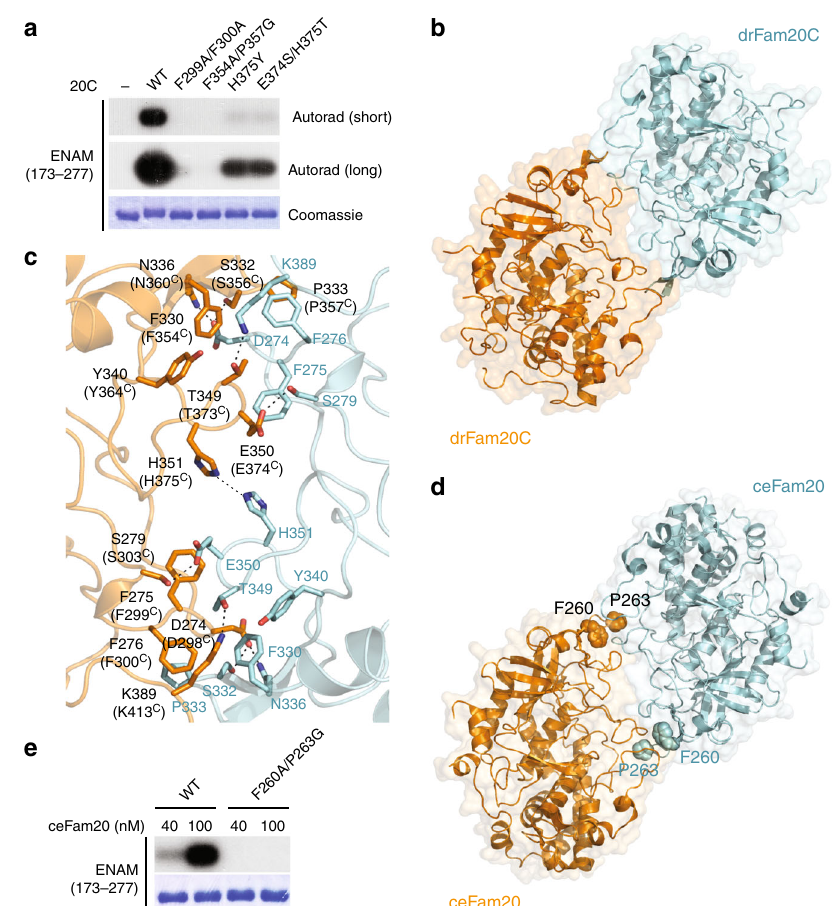
Fig. 3 Evolutionarily conserved dimer formation is required for Fam20C activity. a Fam20C mutants display reduced kinase activity. b The crystal structure of drFam20C reveals a homodimer structure resembling the human Fam20A − Fam20C heterodimer. c Detailed view of the drFam20C homodimer interface. All the residues involved in drFam20C homodimer formation are conserved in human Fam20C (the corresponding residues in human Fam20C are indicated in brackets). d Reexamination of the crystal structures of ceFam20 reveals a homodimer structure present in the crystal lattices of two different crystal forms (PDB entries 4KQA and 4KQB). Phe260 and Pro263 are highlighted. e The kinase activity of ceFam20-F260A/P263G is